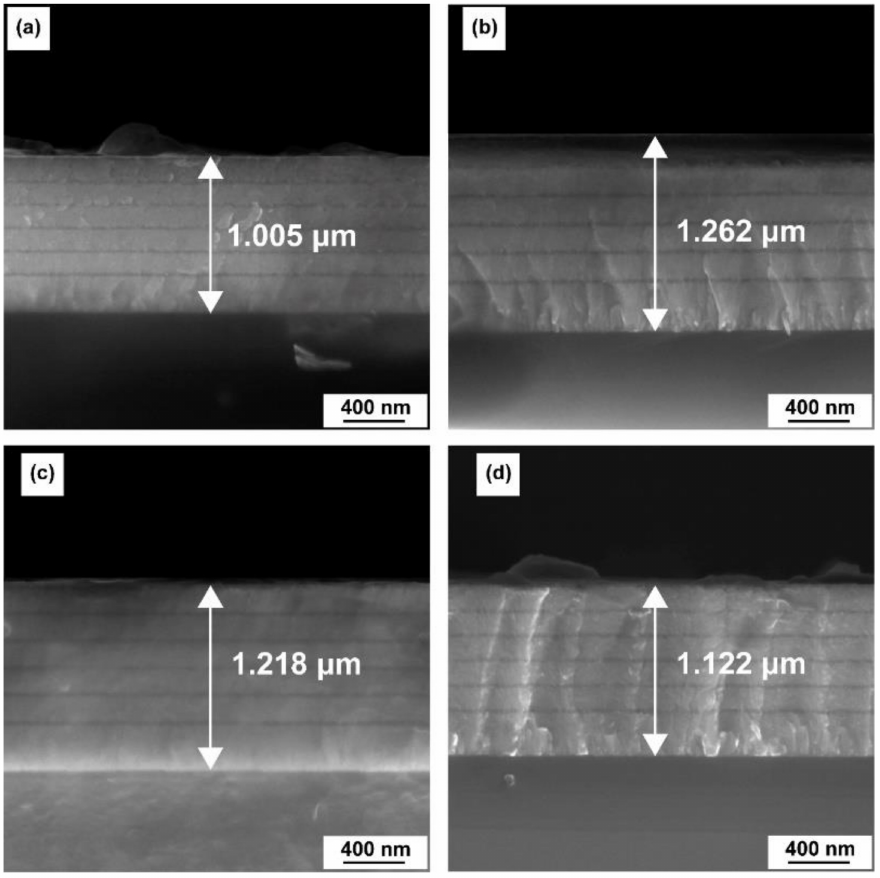
Figure 7. Cross-section of coatings deposited at various V s under Secondary Electron Images (SEI) mode. ( a ) − 30 V, ( b ) − 60 V, ( c ) − 100 V, and ( d ) − 150